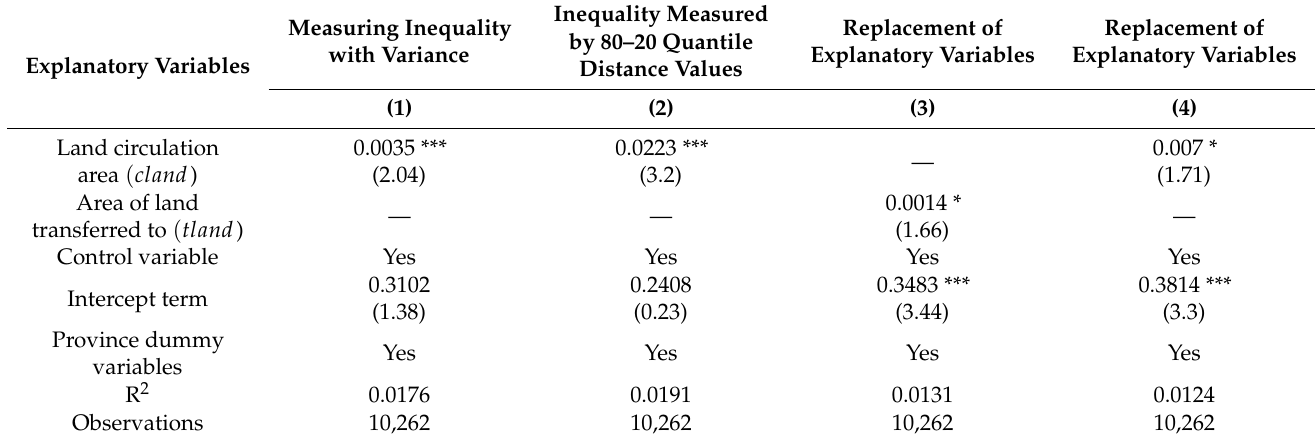
Table 3. Robustness test